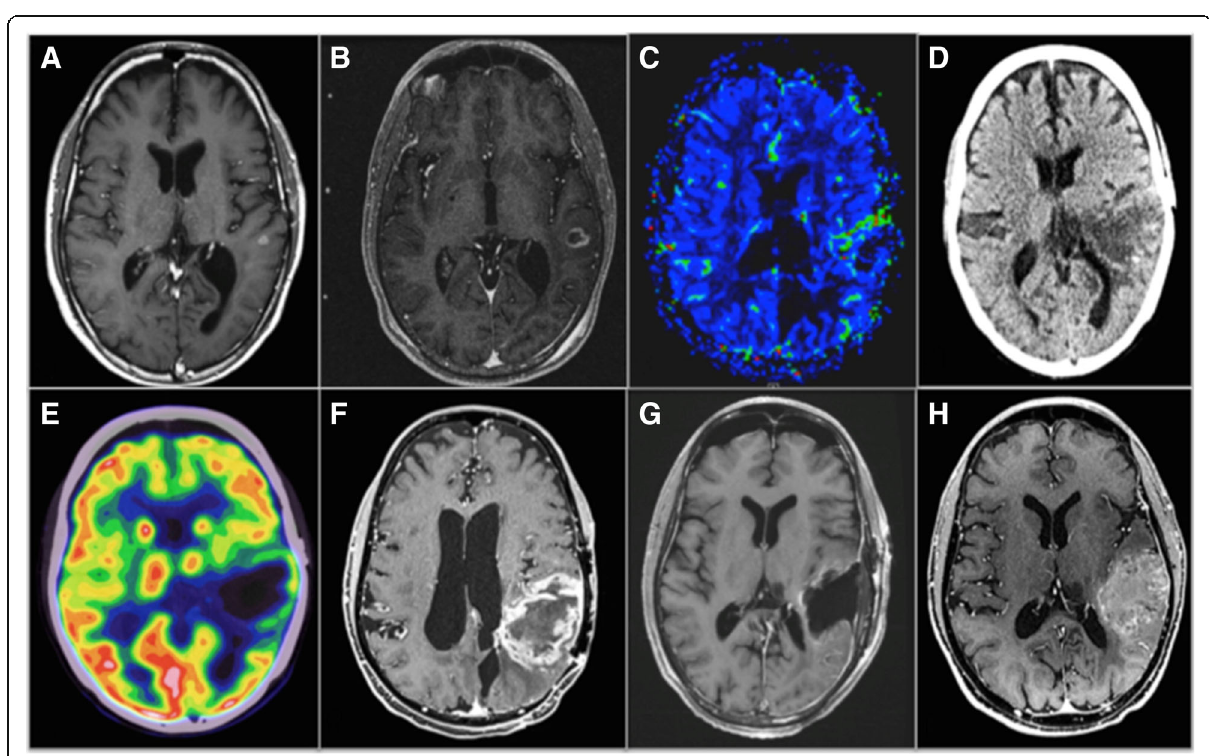
Fig. 3 Multimodal image-guided management in a PD-1, PD-L1, TILs glioblastoma. This case illustrates the potential interest of pre- immunotherapy immuno-PET imaging biomarkers since the immune escaping environment (i.e., pathology was negative for PD-1, PD-L1 and, tumor infiltrating lymphocytes) explaining the insensitivity of this patient to immunotherapy was demonstrated only on the pathology post- resection at the end of immunotherapy. Existing imaging techniques demonstrated treatment insensitivity ( a – h ) but were not able to decipher the immune contexture for an early prediction of outcome. Imaging of a patient with recurrent glioblastoma in the left parietal lobe treated with combined immunotherapy (nivolumab) and re-gamma knife. MRIs were obtained at 3-month intervals. a Baseline T1 post-contrast MRI prior to immunotherapy and re-gamma knife therapy demonstrating a 6 × 5 mm enhancing lesion in the left parietal lobe. b MRI post-initiation of immunotherapy and pre-re-gamma knife therapy showing interval growth of the lesion. c MRI perfusion demonstrating growth and increased flow along the anterior margin of the tumor. d , e PET/CT demonstrating continued growth and increased FDG activity along the margin of the lesion. f Subsequent MRI demonstrating significant growth, increased peripheral nodular enhancement, and central necrosis. g Post-contrast MRI post-resection showing mild non-specific enhancement around the resection margin. h Follow-up MRI 7 months after resection demonstrating progression of